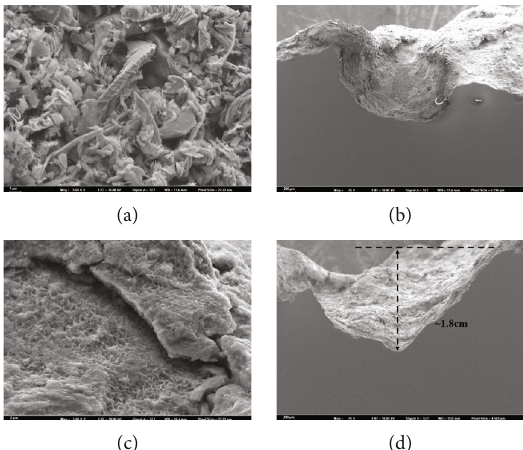
Figure 4: (a) SEM morphologies of the WZ; (b) cross-sectional image of the WZ; (c) SEM morphologies of the HAZ; (d) cross-sectional image of the HAZ.